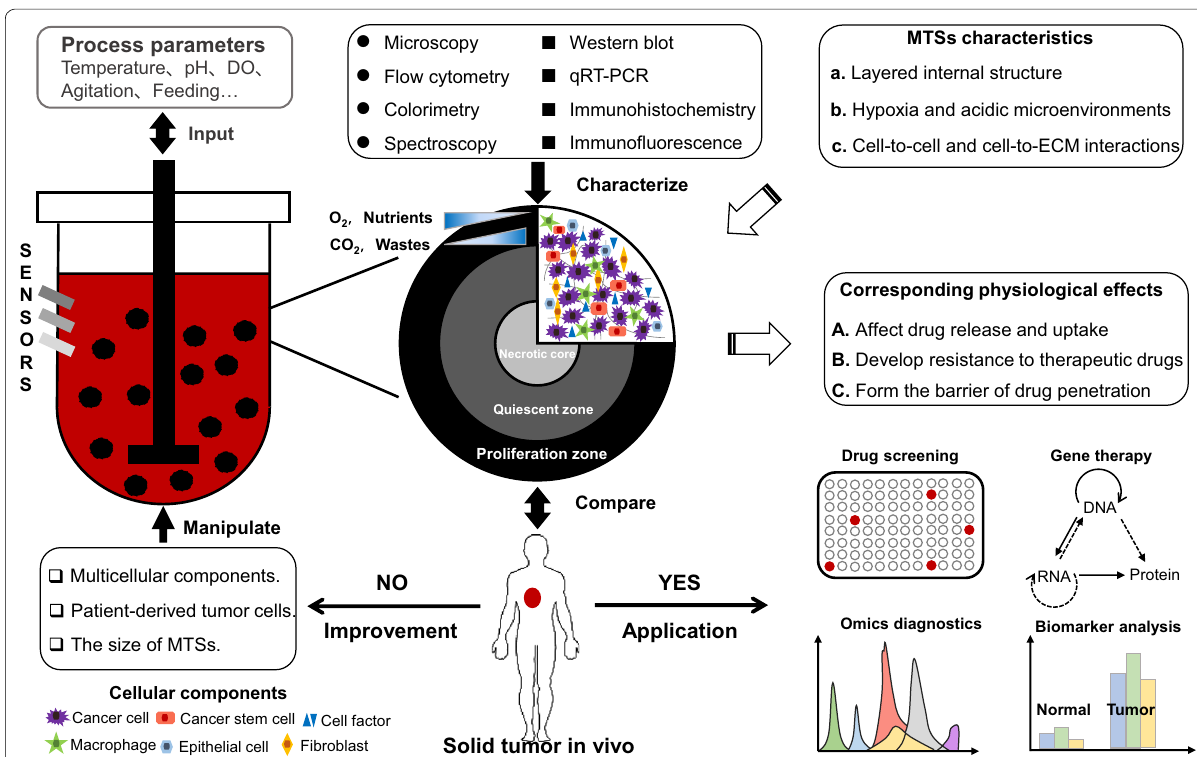
Fig. 3 Adaptable bioreactor culture system can be used for massive production of multicellular tumor spheroids serving to preclinical drug screening and evaluation. Process sensors can aid the real-time observation and regulation of process parameters, and the microenvironment surrounding the MTSs can be manipulated to allow the environment (e.g., nutrients, metabolic wastes and cell types) in the bioreactor can be as close as possible to the microenvironment of tumor in vivo. To ensure that the MTSs generated in the bioreactor can be readily applied to preclinical biomedical research, comparing phenotypic landscapes between these individualized MTSs and solid tumors in patients is a must; the resulting MTSs similar to human solid tumors could be used in drug screening, gene therapy and tumor metabolomics